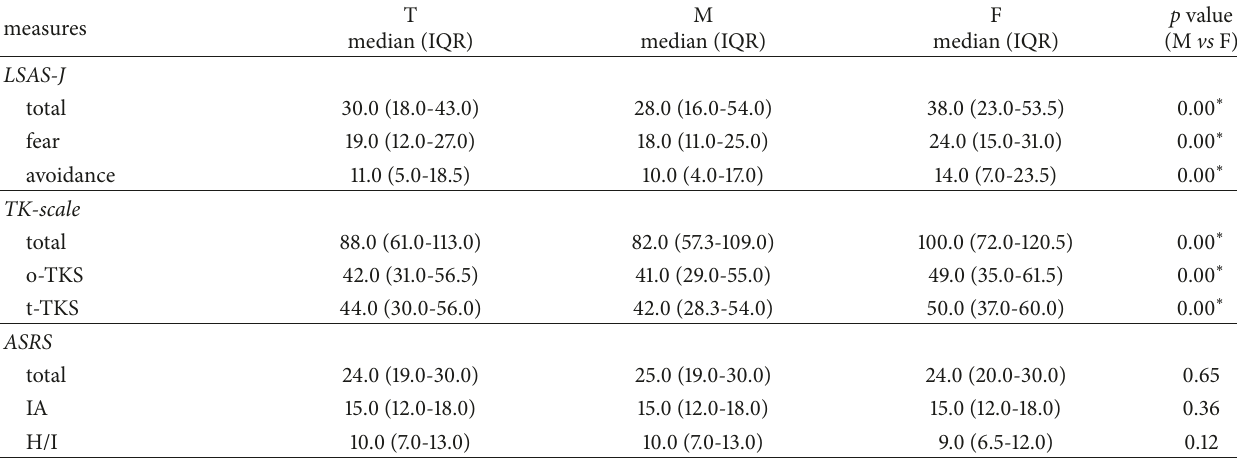
Table 1: Scores on the LSAS-J, TK scale, and ASRS.